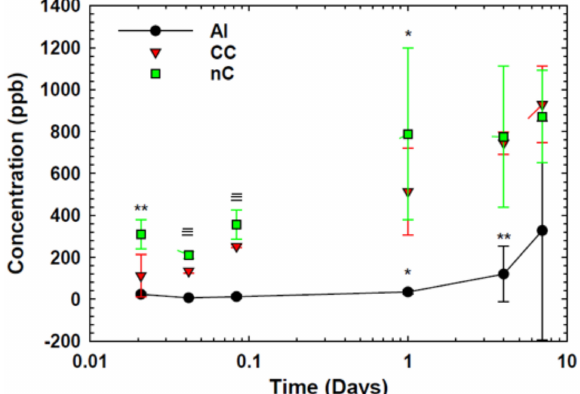
Figure 27. Cu ion release assay for nanostructured Cu and conventional Cu cold sprayed samples with an Al control